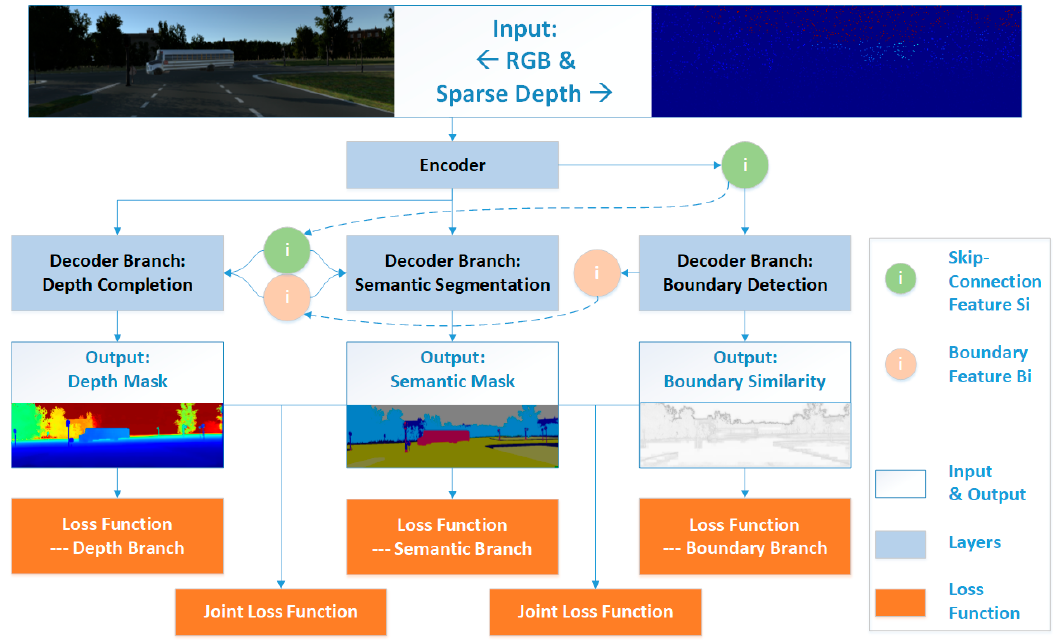
Figure 1. Proposed simultaneous semantic segmentation and depth completion multi-task network (SSDNet). Boundary constraint is embedded into the two major tasks via multi-scale feature sharing and cross-task joint loss function.